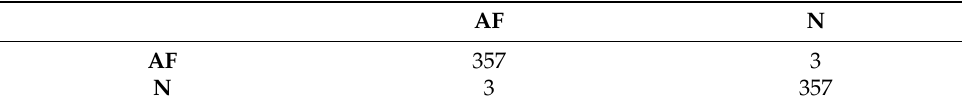
Table 5. Classification results of the diagnosis model in the AFDB test set.